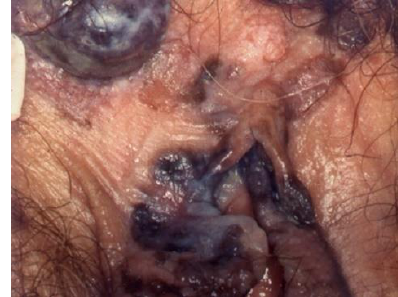
Figure 14. Melanoma.